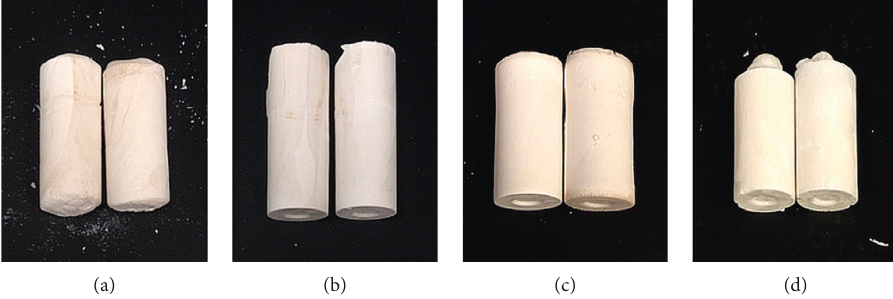
Figure 1: Photographs of cylindrical aerogels: (a) pure nanoclay aerogel; (b) Aerogel_55; (c) Aerogel_61; (d) Aerogel_67.